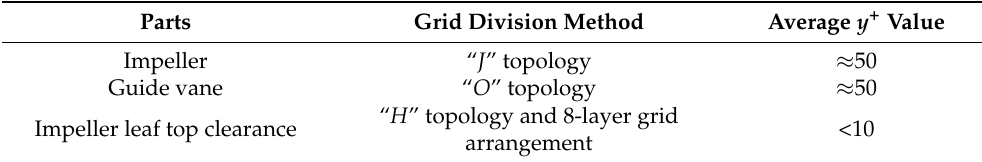
Table 2. Grid parameters of main components of axial flow pump.